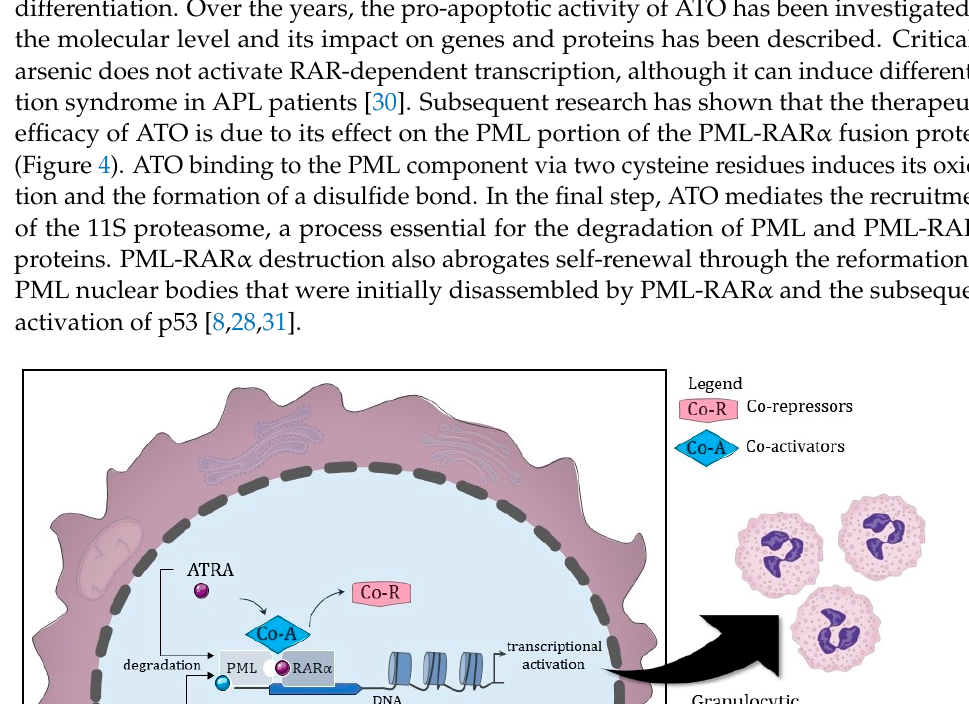
Figure 5. CD33-targeting Gemtuzumab-Ozogamicin . Once the CD33 receptor drives the molecules to endocytosis and degradation, the cytotoxic agent causes DNA damage and promotes cell death. FLT3 is a tyrosine kinase receptor and an important early regulator of hematopoiesis